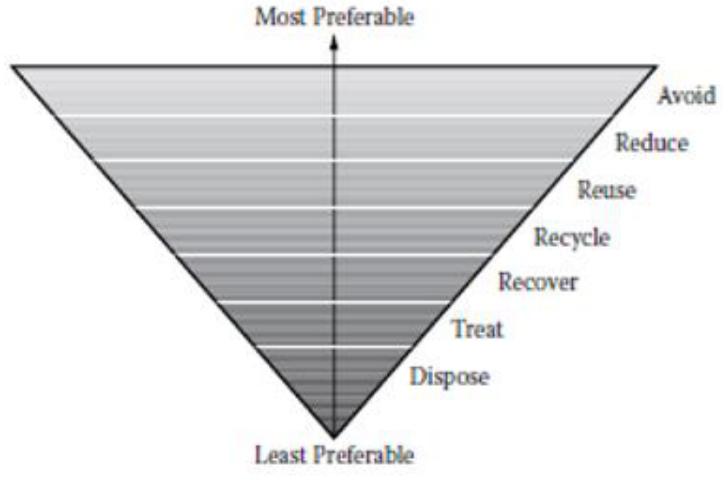
Figure 5. Hierarchy of waste management